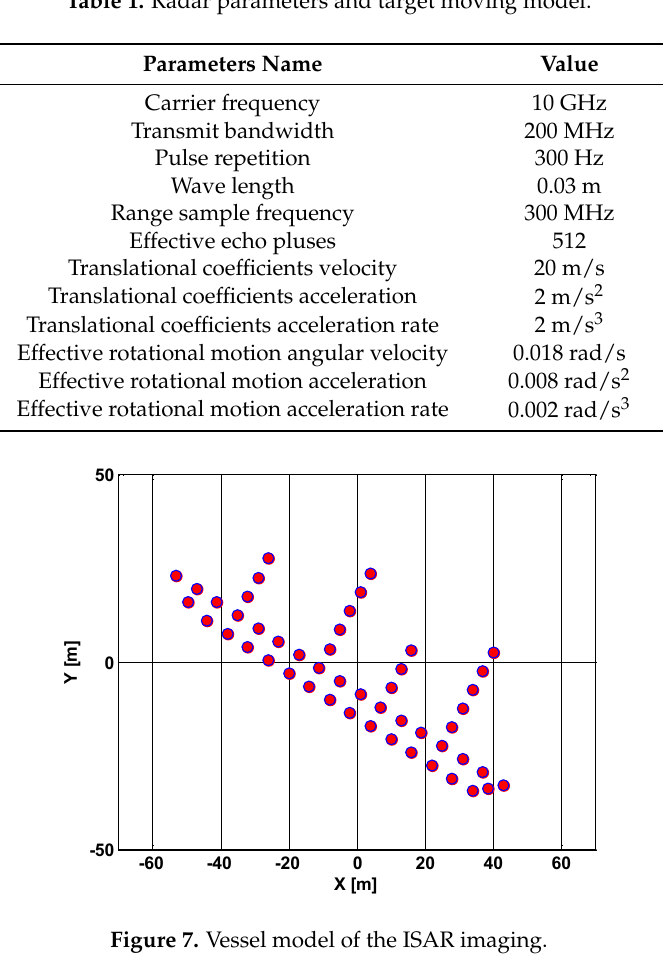
( b ) Figure 8. Range compression and imaging result without migration compensation. ( a ) Range compression; ( b ) RD imaging result.